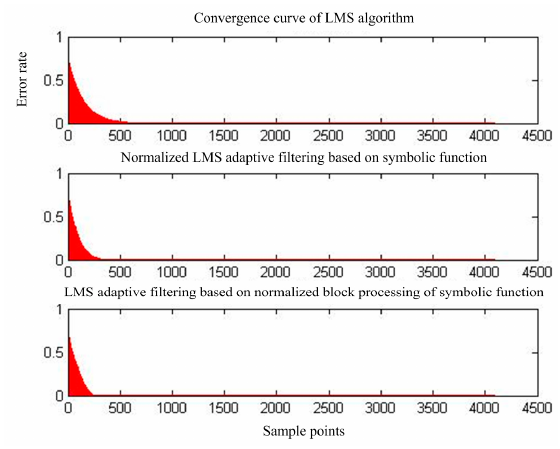
Figure 8. Mean square error convergence of the three adaptive interference cancellation algorithms.